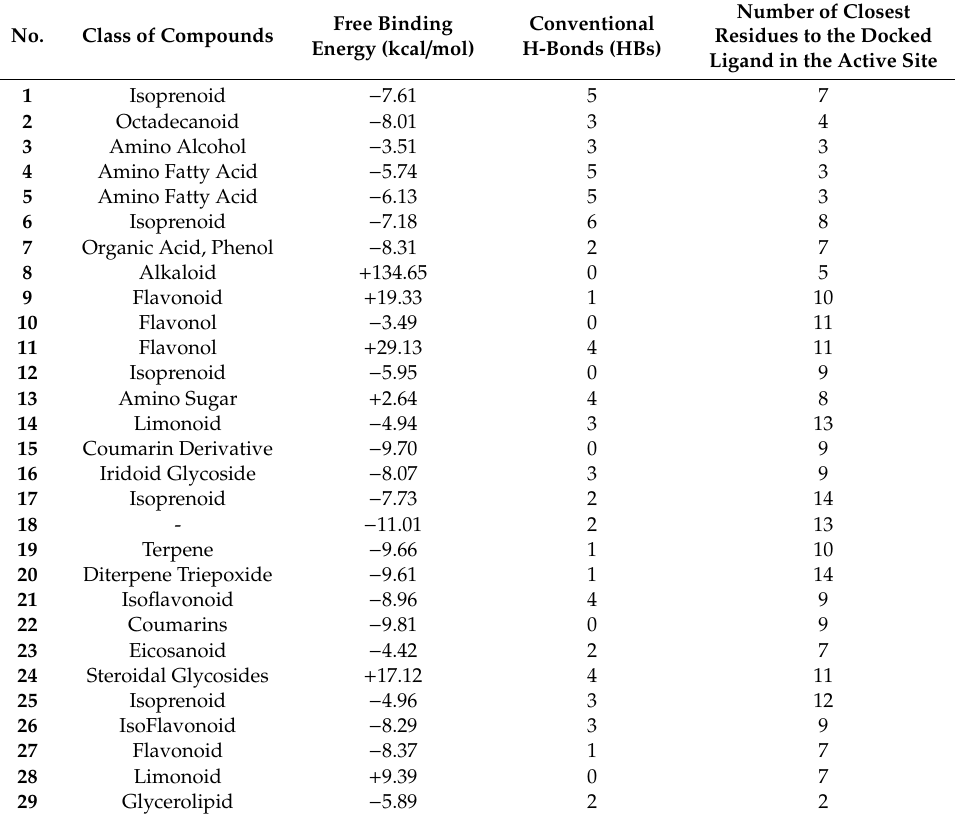
Table 7. Docking binding energies, conventional hydrogen bonding, and the number of closest residues to the docked compounds into the active site of the human androgen